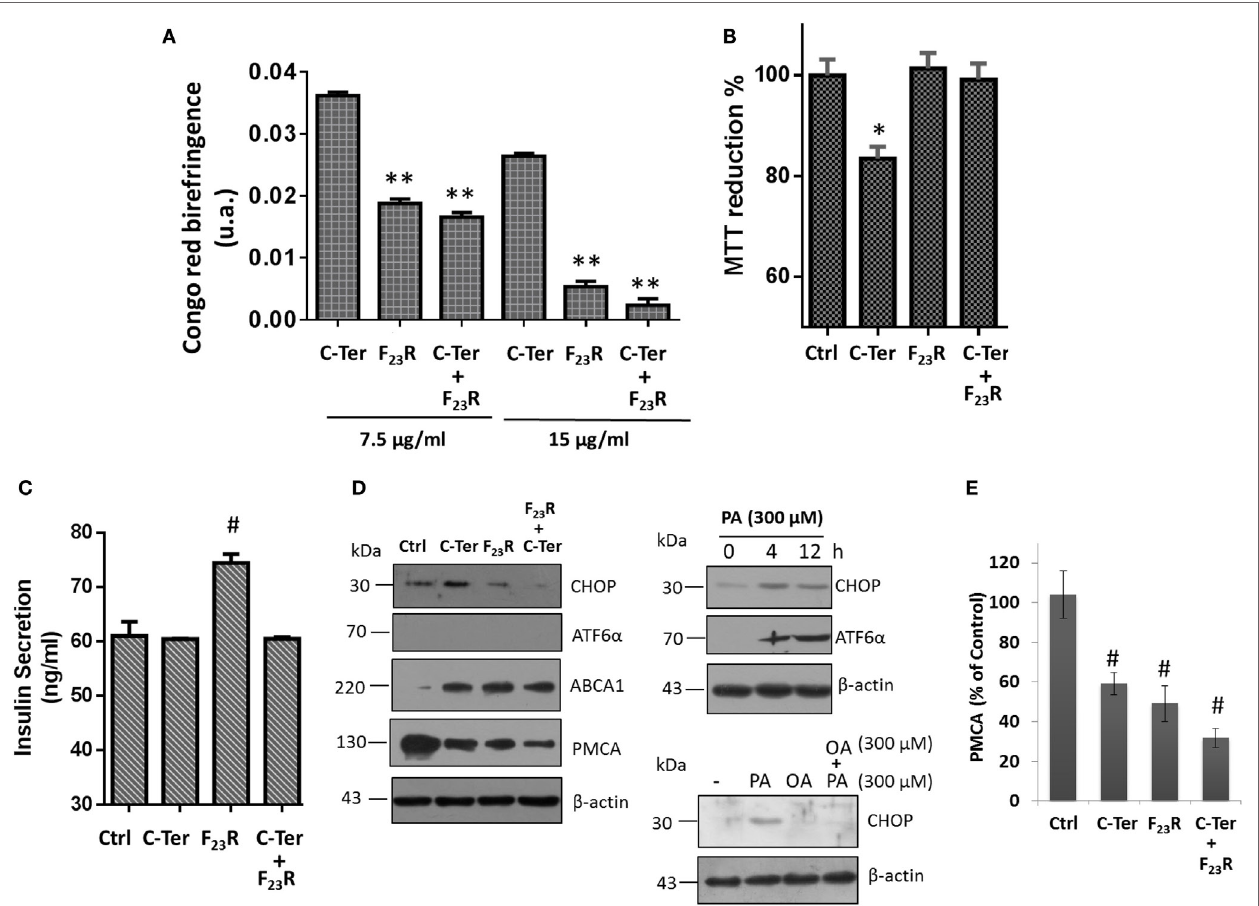
FigUre 6 | Modulation of amyloid aggregation in the native C-terminal dependent of treatment with F 23 R. (a) Characterization of beta-sheet structures by Congo-red birefringence assay under equimolar concentrations of peptides. (B) Beta-cell viability assay by MTT at peptide concentrations of 7.5 µg/mL. (c) Insulin quantification in extracellular media under the same conditions. Mean values are presented ( n = 6, X ± SD) * p < 0.001, ** p < 0.005. (D) Expression of CHOP and ATF6 α transcription factors, as well as PMCA and ABCA1 in islet amyloid polypeptide peptide treatments. In this experiment, several controls were evaluated, effect of PA incubation on the expression of CHOP and ATF6 α at 4 and 12 h. Under the same concentration (300 µM), oleic acid effect was evaluated on CHOP expression. β -actin was used as a load control. (e) Quantification of PMCA expression compared to control, # p <